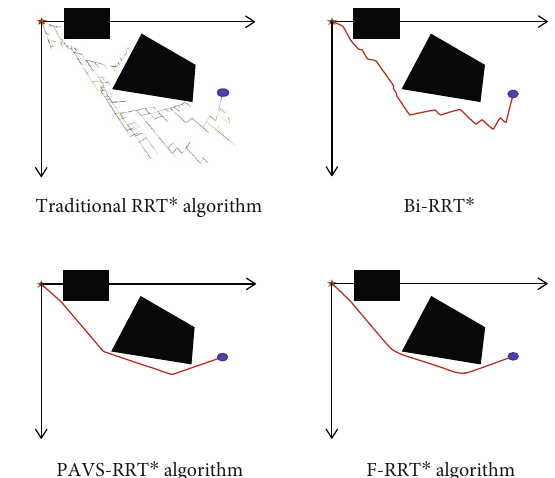
Figure 12: Path planning e ff